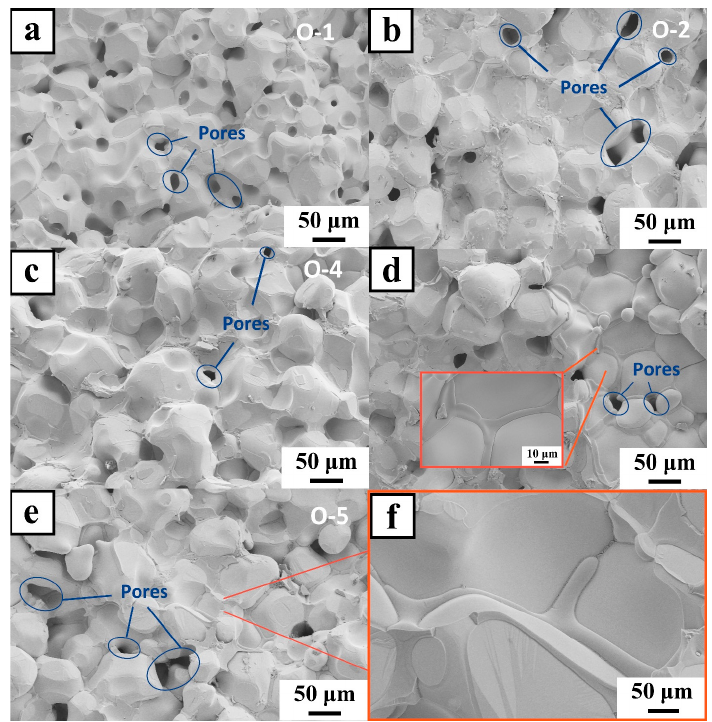
Figure 6. The fracture surfaces of Mo-sintered samples: ( a ) O-1 sample with 3700 wppm O; ( b ) O-2 sample with 4500 wppm O; ( c – f ) O-4 and O-5 samples with 6200 wppm and 8600 wppm O, respectively. The circles outline the sintered pores in Mo.